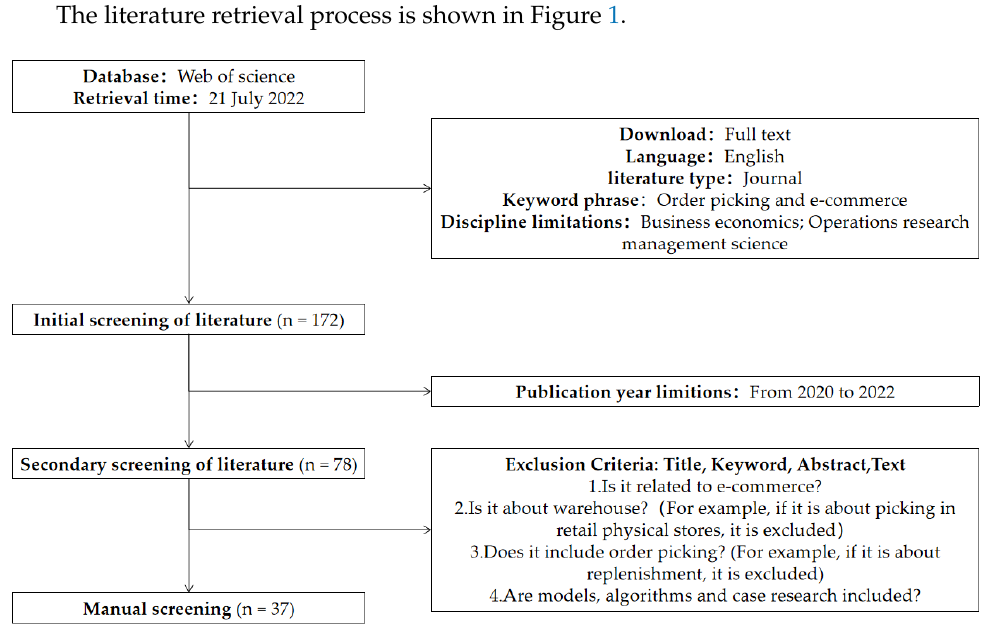
Figure 1. The process of database retrieval and literature screening.